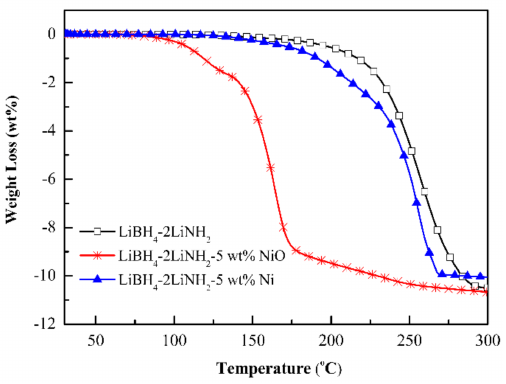
Figure 9. Non-isothermal dehydrogenation curves of the LiBH 4 -2LiNH 2 with different